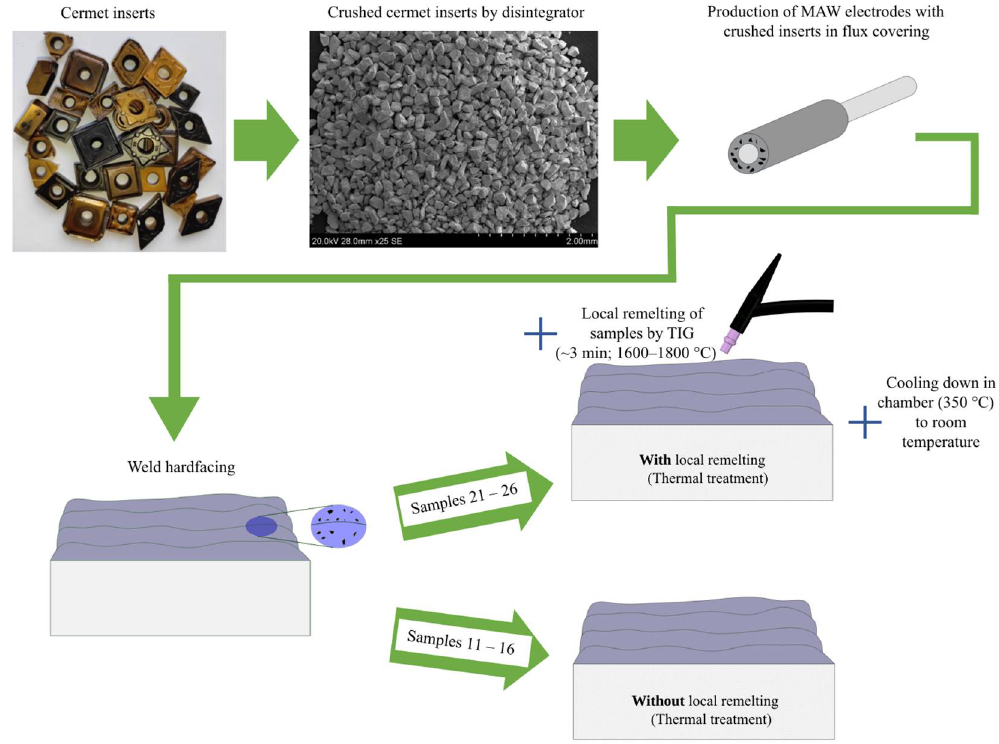
Figure 2. Schematic diagram of preparation, welding, and local remelting of the